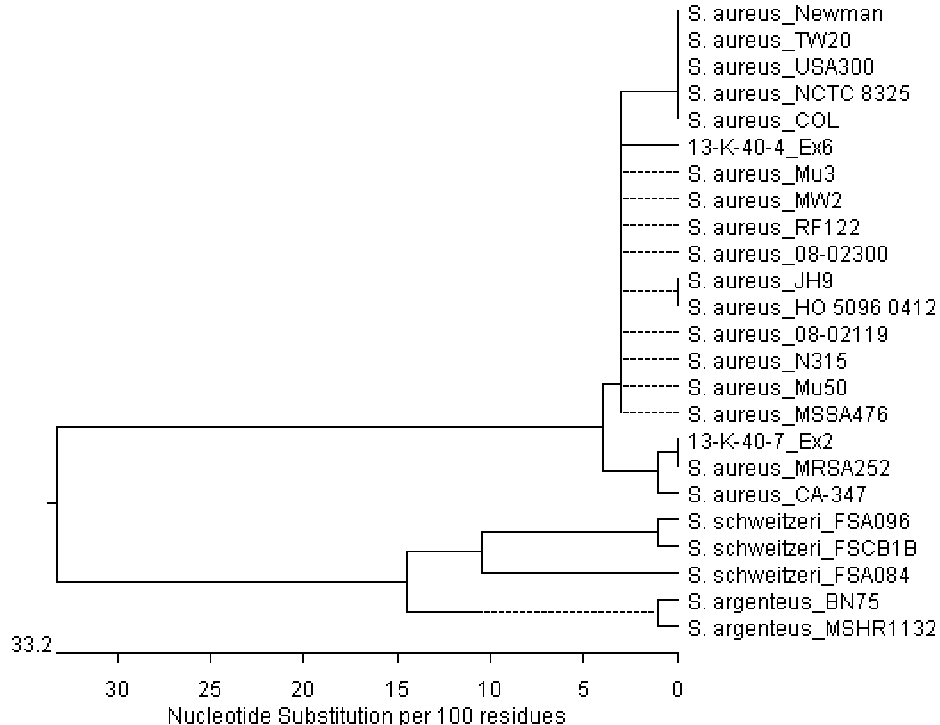
Figure 4. Phylogenetic relations based on the alignment (Figure S7 in supplementary data) of two